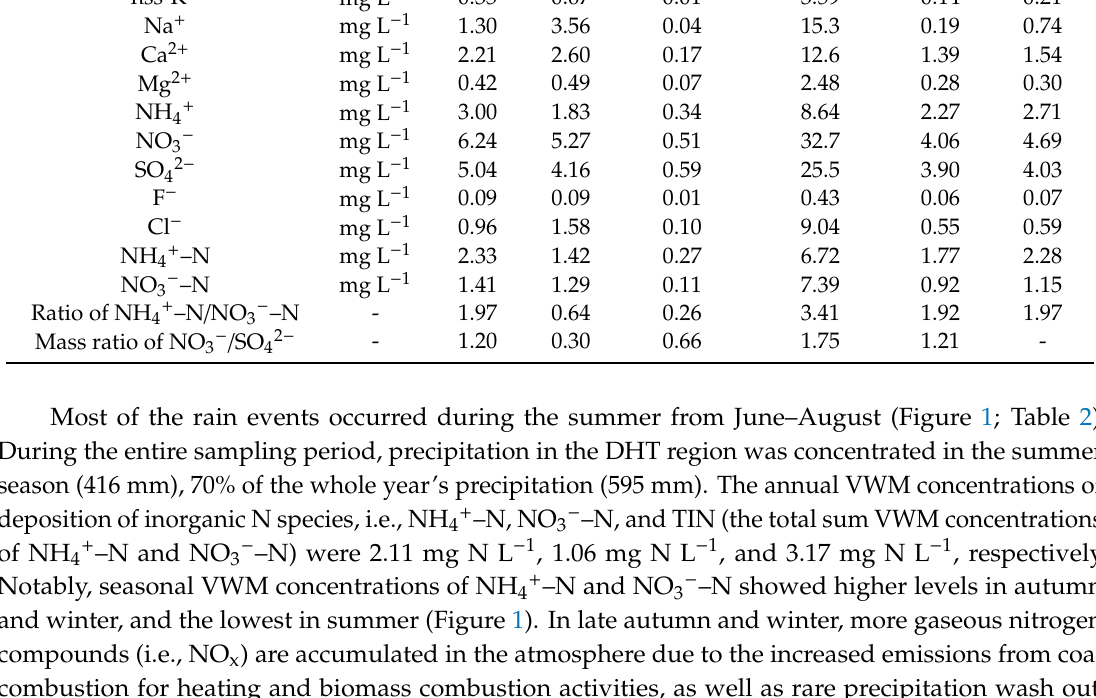
Table 1. The statistical summary of water-soluble ions in precipitation and their volume-weighted mean (VWM) concentrations from July 2019 to June 2020. nss = Non-sea salt. Parameter